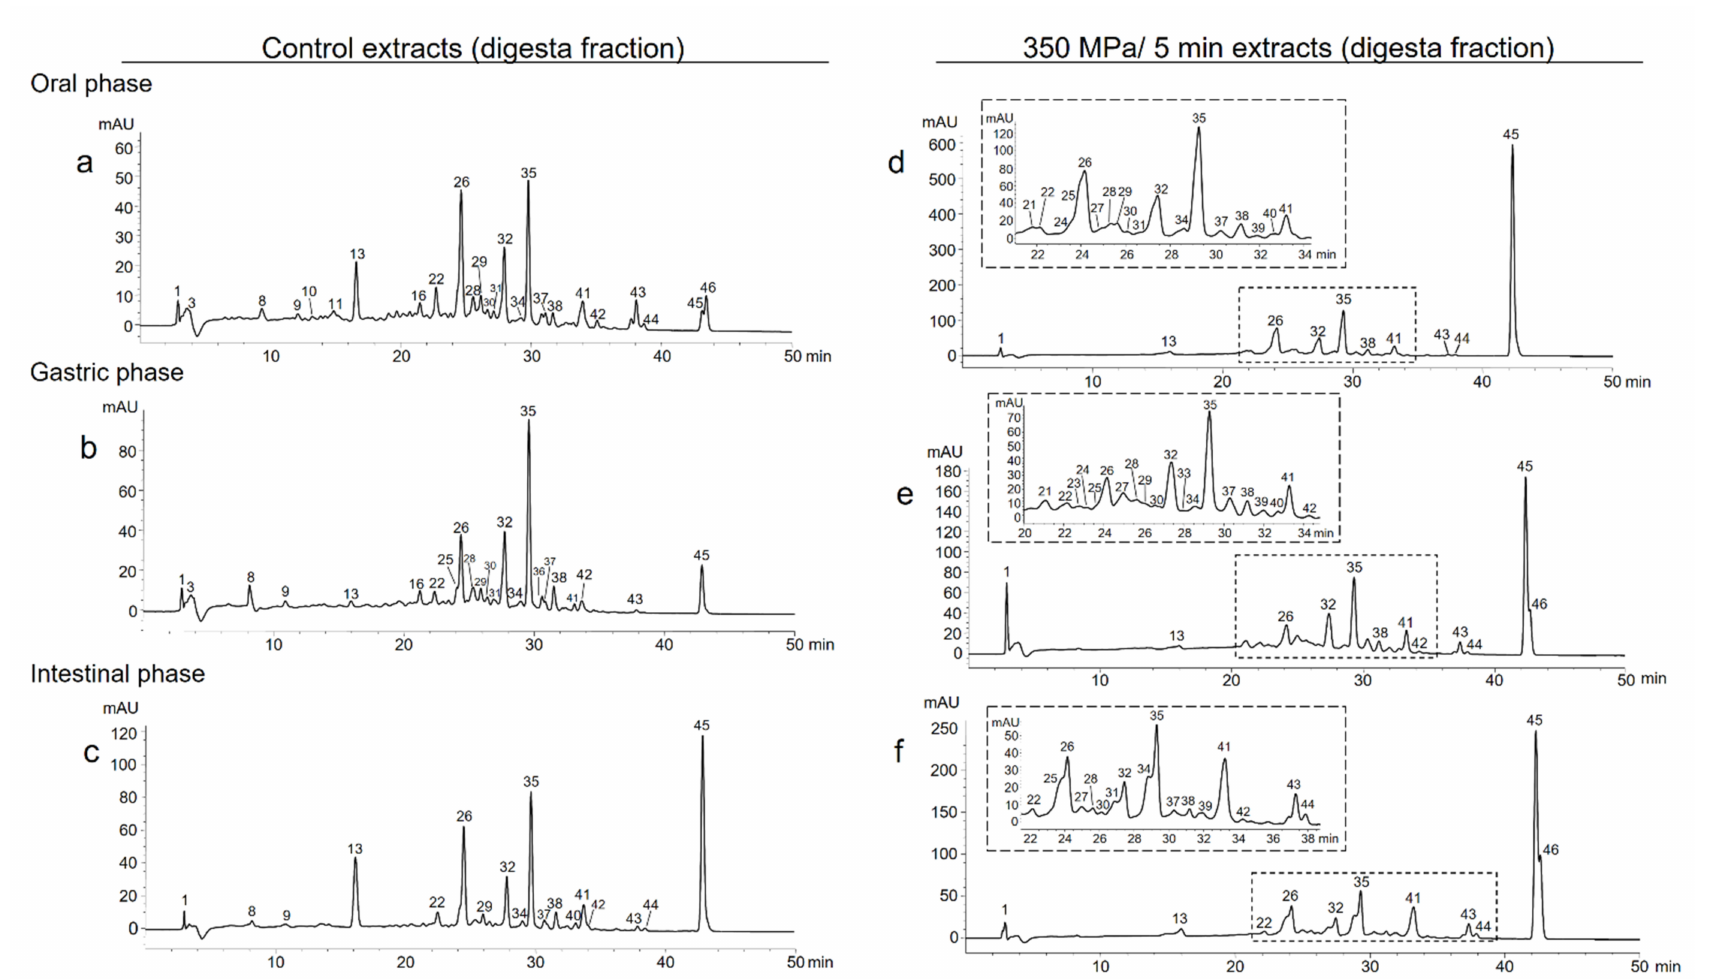
Figure 1. C 30 reversed-phase chromatograms of carotenoids at 450 nm obtained from cv. Sweet Mary papaya ( Carica papaya L.) pulp after in vitro gastrointestinal digestion (digesta fraction) of untreated (control) sample—( a ) oral phase; ( b ) gastric phase; ( c ) intestinal phase—and submitted to HHP (350 MPa/5 min) sample—( d ) oral phase; ( e ) gastric phase; ( f ) intestinal phase. Peak identities in Table